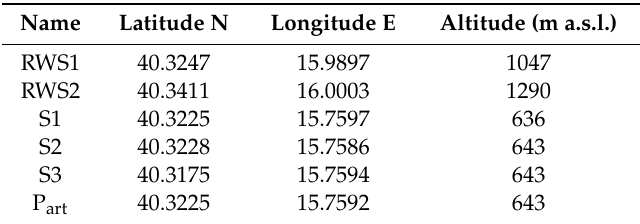
Table 1. The coordinates expressed in Latitude N, Longitude E, and the altitude of the two rain samplers (RWS1 and RWS2), springs, and the artesian